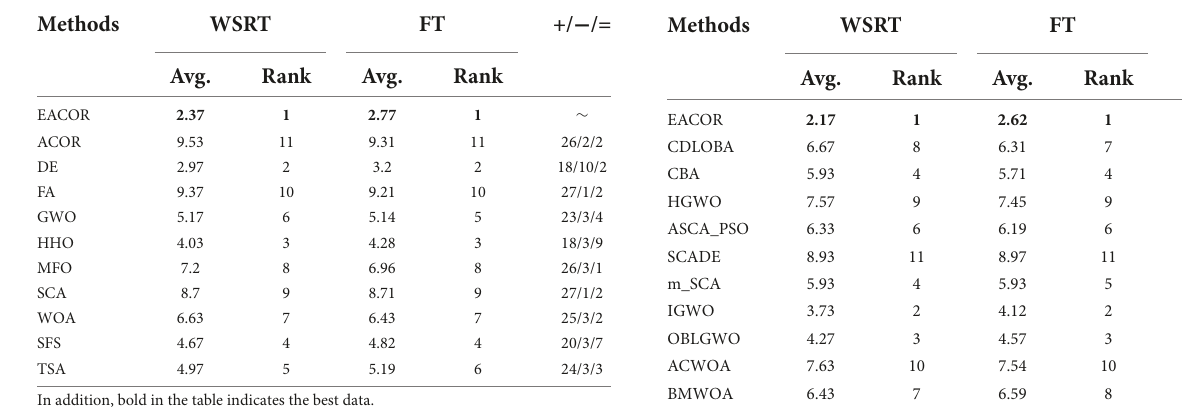
TABLE 6 Comparative results of EACOR with ten original algorithms. TABLE 7 Comparative results of EACOR with ten peers.